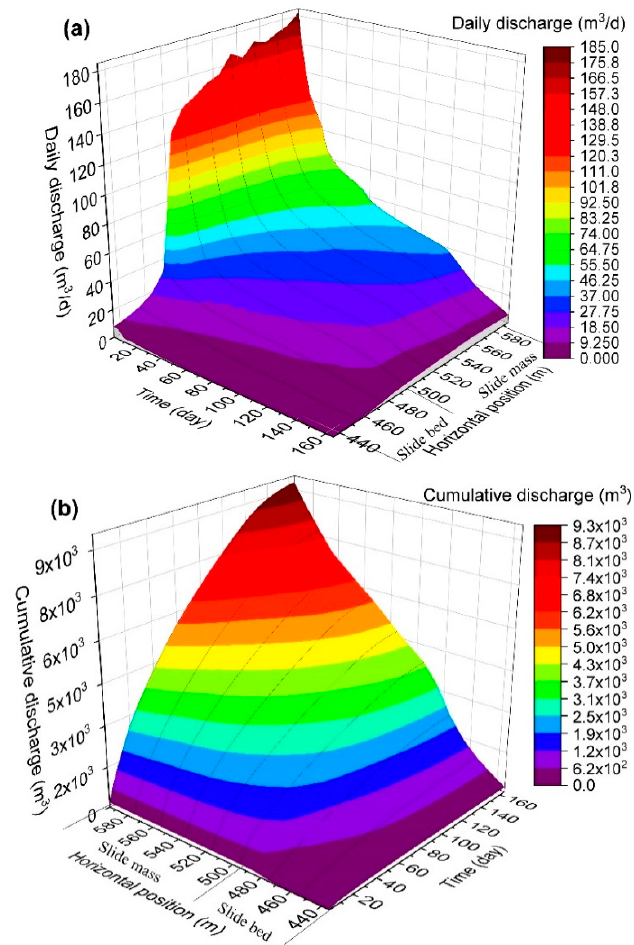
Figure 8. Cloud map showing the daily discharge ( a ) and cumulative discharge ( b ) with different draining well locations and time. The model is two dimensional and the discharges are in per-unit width.